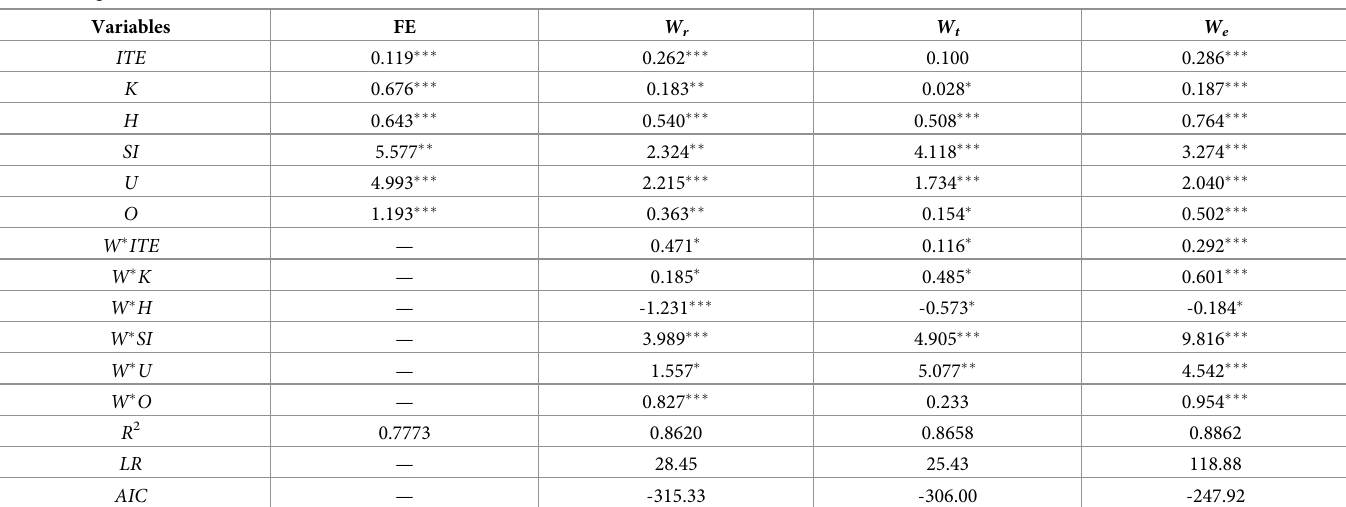
Table 4. Regression